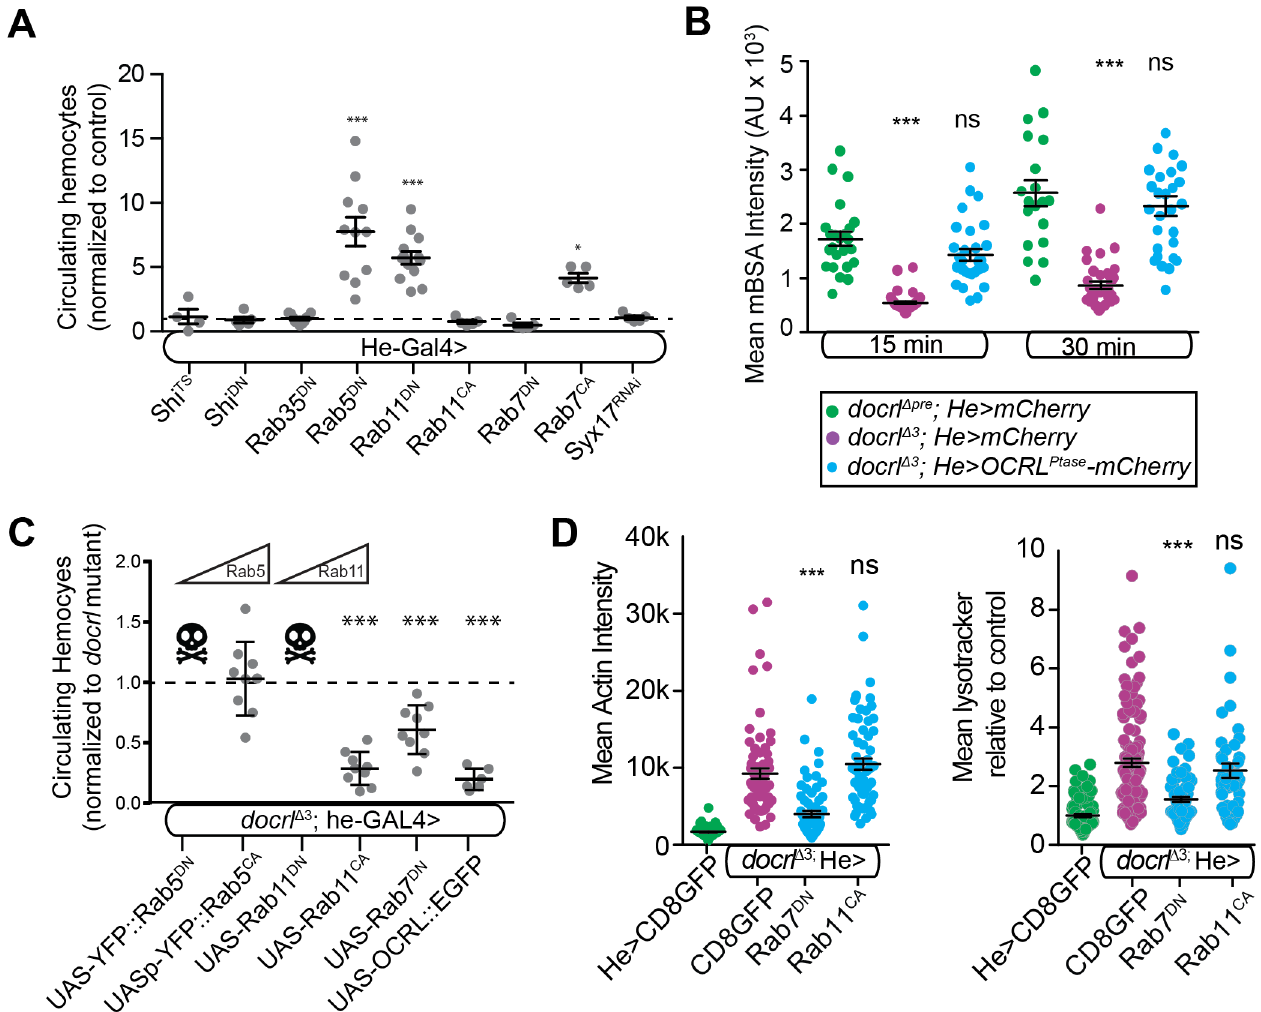
Fig 7. Endosomal sorting defects underlie hemocyte activation in docrl mutants. (A) Relative hemocyte number in larvaewith hemocyte- specific manipulation of the indicatedRab GTPases. Inhibitingthe internalizationstep of endocytosishas no effect on hemocyte number, while manipulationof endosomalsorting recapitulates the docrl mutant phenotype. Statistical significancenoted reflects pairwisetests with wild type control. (B) The phosphatase activity of dOCRL is sufficient to rescue scavengerreceptor endocytosis of mBSA. (C) Manipulationof endosomal sorting via Rab11and Rab7 rescue docrl- inducedhemocyte overabundance. Data sets were each normalized and statistical significance noted relative to docrl mutant controls taken at the same time. Data are presented as mean +/- SEM. (D) Expression of Rab7 DN , but not Rab11 CA , rescues docrl -inducedactin (left) and Lysotracker (right) accumulation. Individual values in A,C are independentsamplespooledfrom 2–4 larvae. Multiple independent experiments are shown together for clarity, all statistical comparisons reflect independentcontrols. Data points in B and D represent single cells pooledequivalently from three independent larval collections.Statistical comparisons shown in B and D are to the relevant control group (green). Associated with S7 Fig.